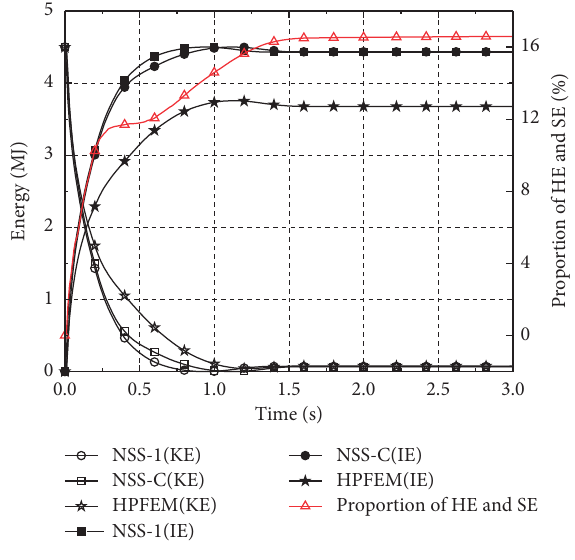
Figure 11: Energy comparison.